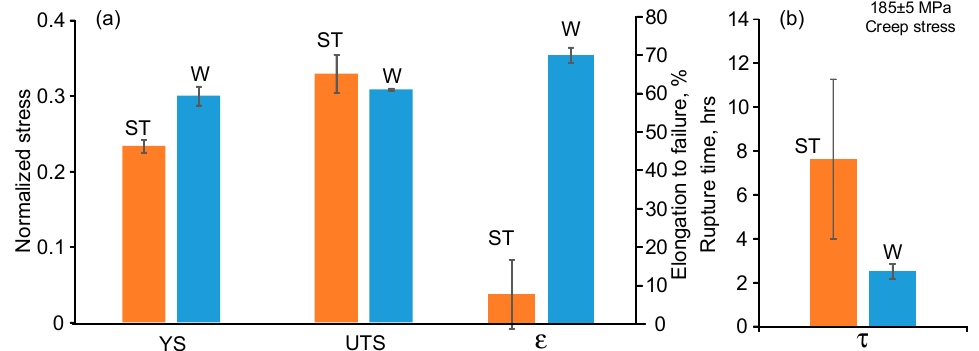
Figure 13. Comparison of the high temperature mechanical properties (760 °C, 1400°F) of the ST LPBF and wrought annealed IN625 alloys: ( a ) strength (YS, UTS) and elongation to failure ( ε ), and ( b ) creep rupture time ( τ ) under a creep stress of 185 ± 5 MPa.